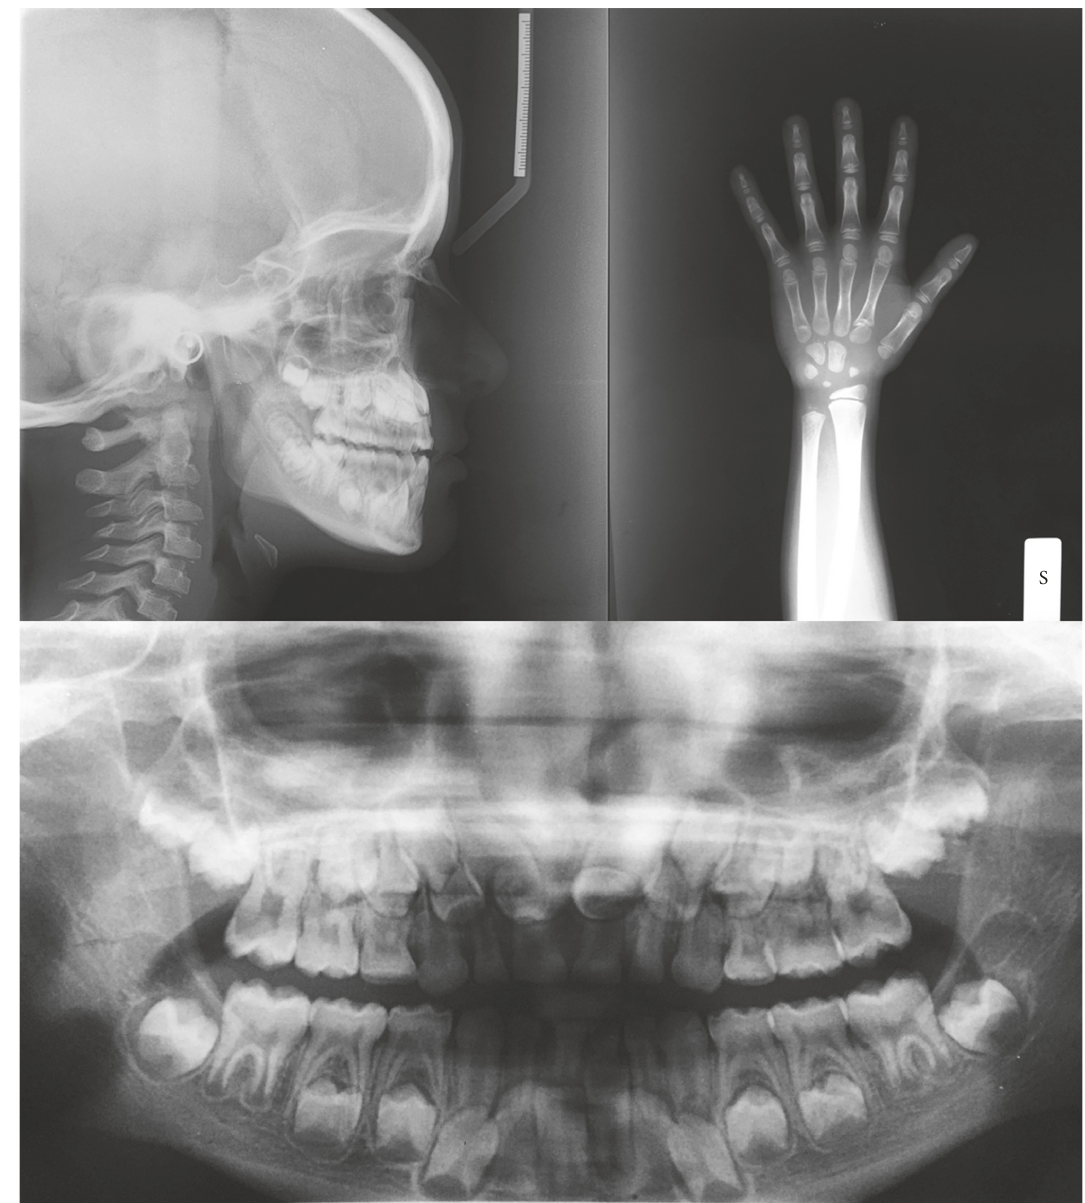
Figure 6: Radiographs of skull and